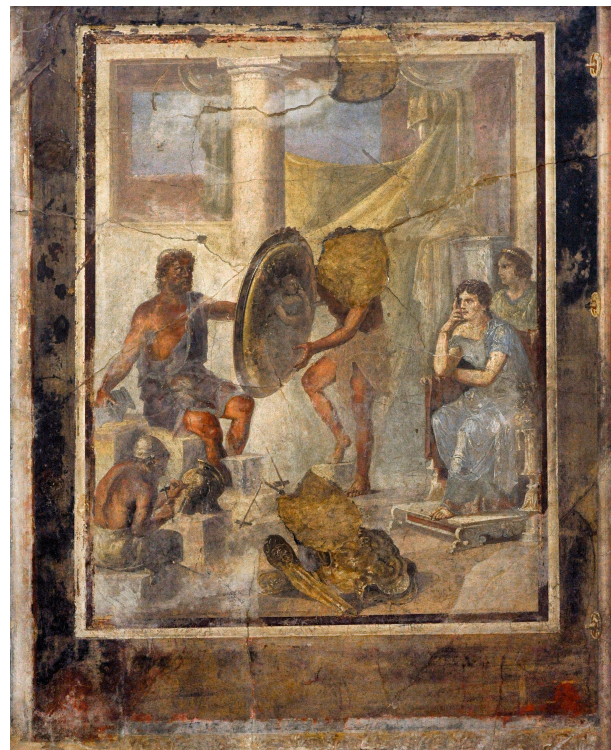
Figure 5. Thetis in the Workshop of Hephaestus, Room E, IX.1.7, Pompeii. Museo Archeologico Nazionale di Napoli, MANN 9529. PRISMA ARCHIVO/Alamy Stock Photo. Used by permission.